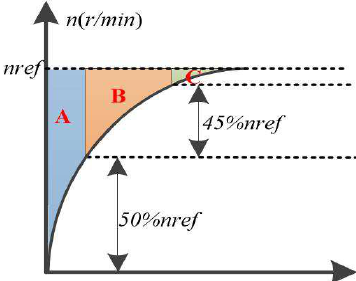
Figure 6. The curve of the ideal